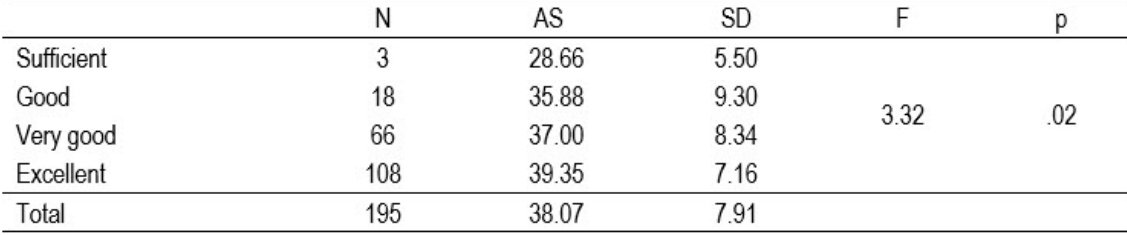
Self-esteem and adolescents’ school